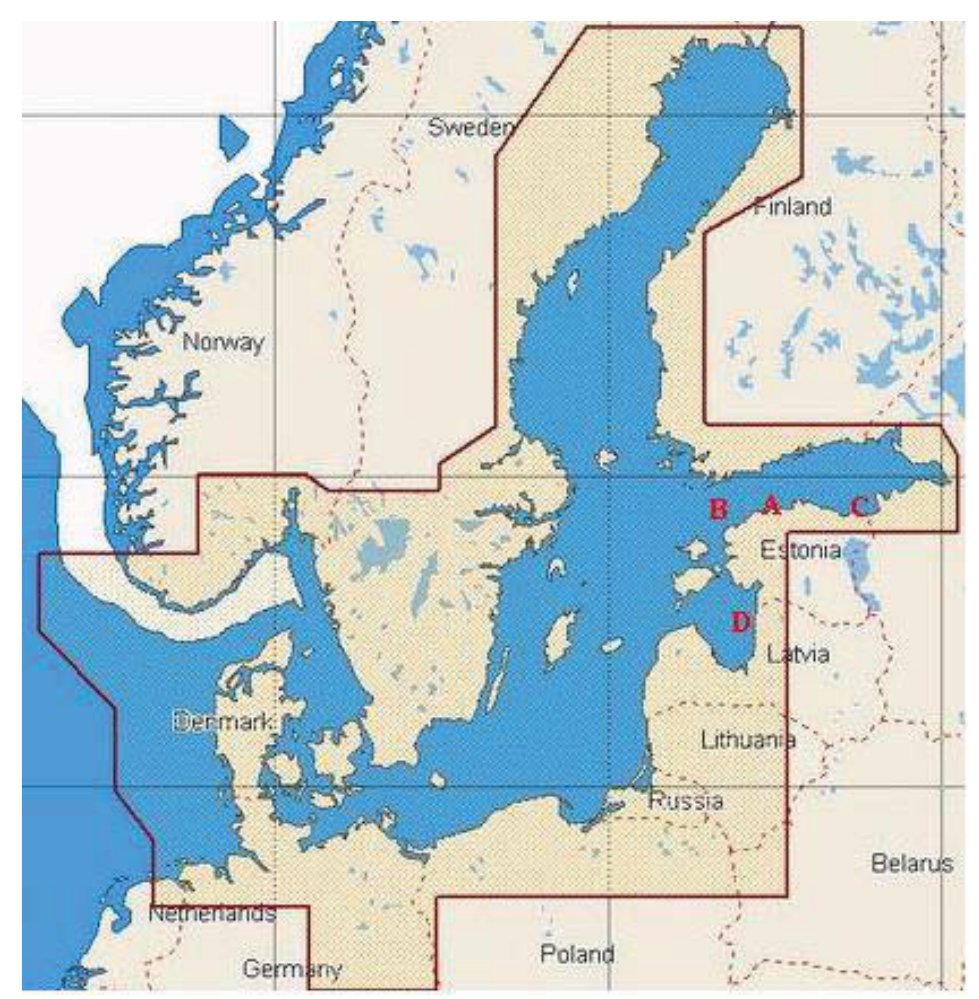
Figure 2. Water samples collection sites from the Baltic Sea regions A, B, C, D near Estonia. Map of the Baltic Sea was obtained from Internet source [32] and